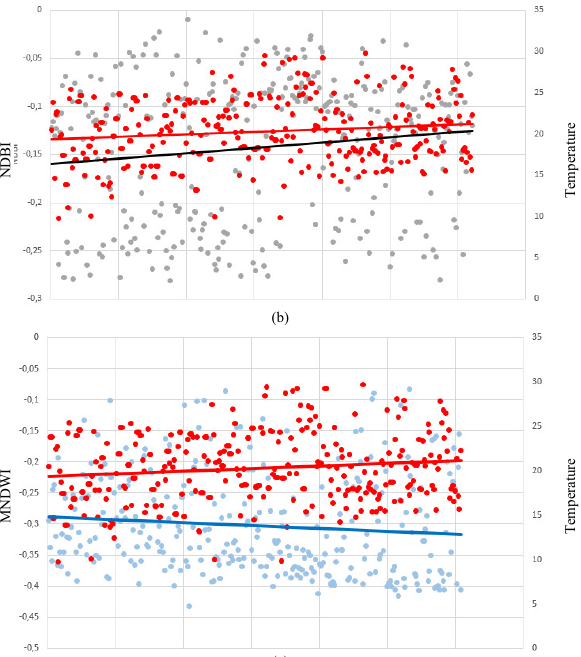
Figure 6. Statistical visualization of mean values acquired based on Landsat imagery during the 30 years for the city of Sao Paulo. (a) Relationship between temperature and NDVI, (b) the relationship between temperature and NDBI and (c) the relationship between temperature and MNDWI.